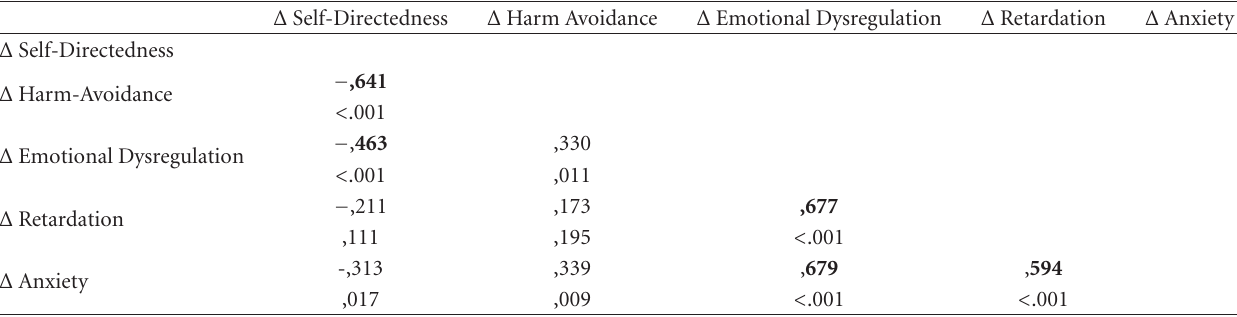
Table 2: Correlations between the changes of ( Δ ) the dimensions of personality (Self-Directedness and Harm Avoidance) and the dimensions of psychopathology (Emotional Dysregulation, Retardation, and Anxiety) in all 58 patients (lower left part of the table). Δ Self-Directedness Δ Retardation Δ Anxiety